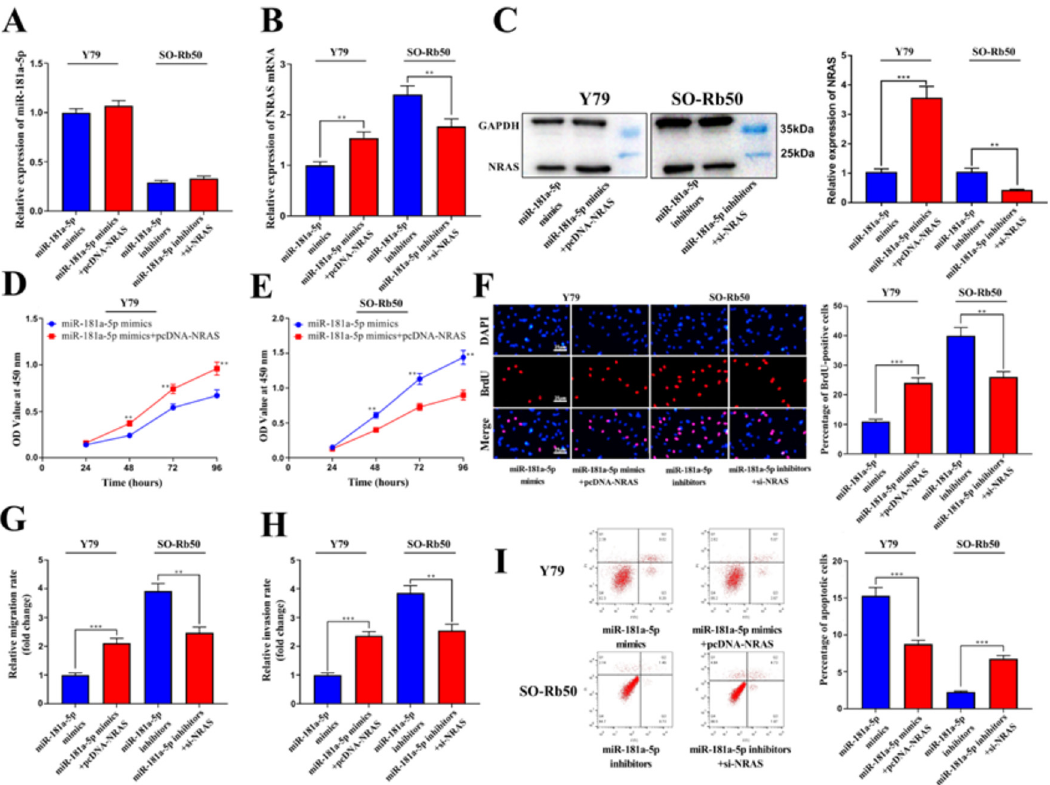
Fig. 5. miR-181a-5p exerts an anti-tumor effect in RB by regulating NRAS. (A-C) qRT-PCR and western blotting assays showed that the expression levels of NRAS mRNA and protein were upregulated in the miR-181a-5p mimics+pcDNA-NRAS group compared with the miR-181a-5p mimics group and downregulated in the miR- 181a-5p inhibtors+si-NRAS group compared with the miR-181a-5p inhibitor group, while miR-181a-5p expression showed no signi fi cant difference. (D-F) CCK-8 and BrdU assays showed that cell proliferation was promoted in the miR-181a-5p mimics+pcDNA-NRAS group compared with the miR-181a-5p mimics group and inhib- ited in the miR-181a-5p inhibitors+si-NRAS group compared with the miR-181a-5p inhibitor group. (G-H) Transwell assay showed that the migration and invasion of RB cells in the miR-181a-5p mimics+pcDNA-NRAS group was promoted compared with the miR-181a-5p mimics group and inhibited in the miR-181a-5p inhibitors +si-NRAS group compared with the miR-181a-5p inhibitor group (magni fi cation: × 200; bar: 25 μ m). (I) Flow cytometry showed that the apoptosis of RB cells in the miR-181a-5p mimics+pcDNA-NRAS group was inhibited compared with the miR-181a-5p mimics group and promoted in the miR-181a-5p inhibitors+si-NRAS group compared with the miR-181a-5p inhibitor group. Protein bands were quanti fi ed by comparison with the endogenous control GAPDH. The data are shown as the mean- ± standard deviation from three independent experiments. ** p < 0.01 and *** p <